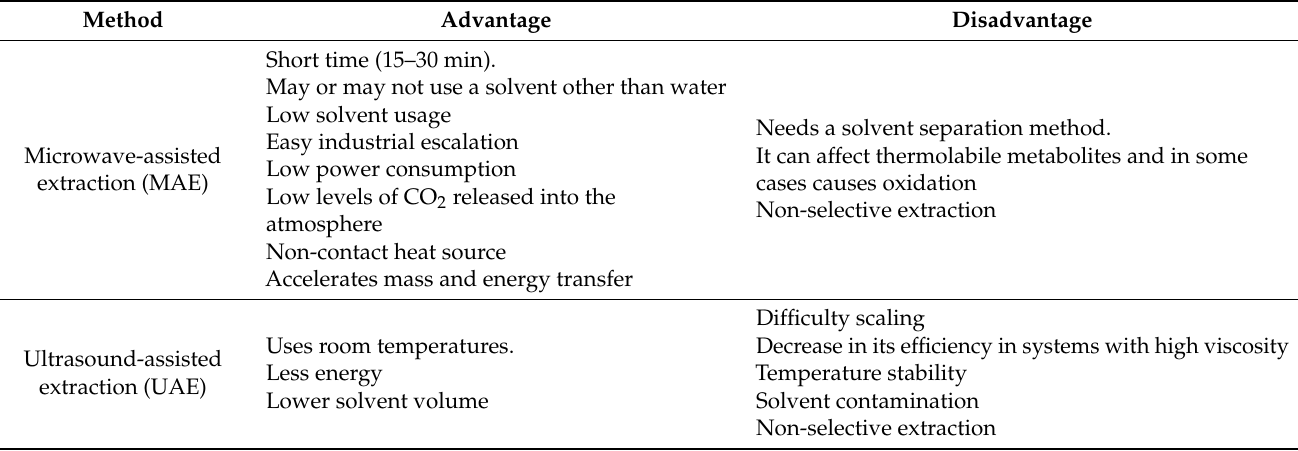
Table 1. Advantages and disadvantages of assorted environmentally friendly techniques for antioxidant extraction.